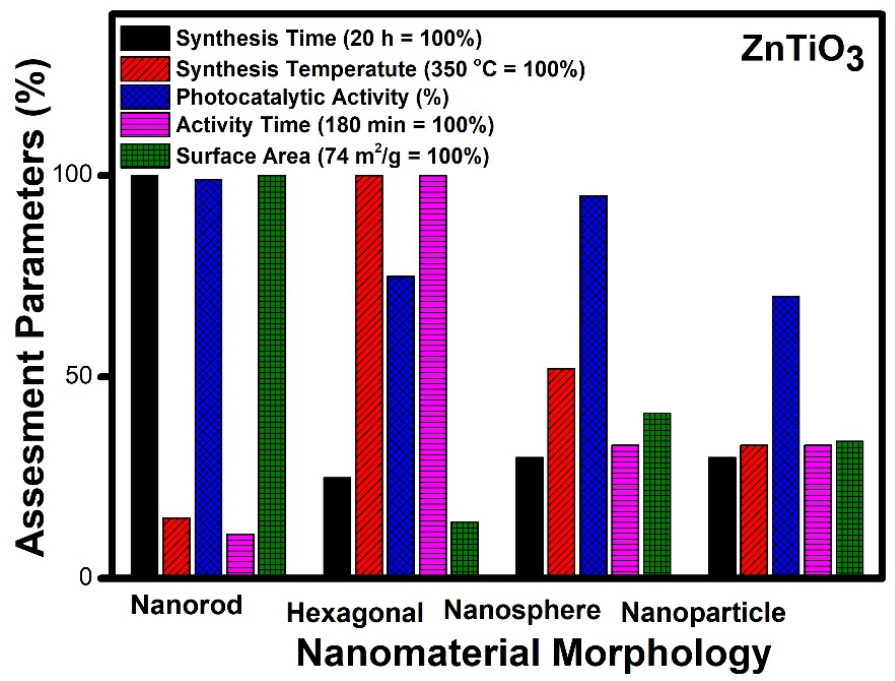
Figure 10. Comparative study of different morphologies of ZnTiO 3 based on various assessment parameters.